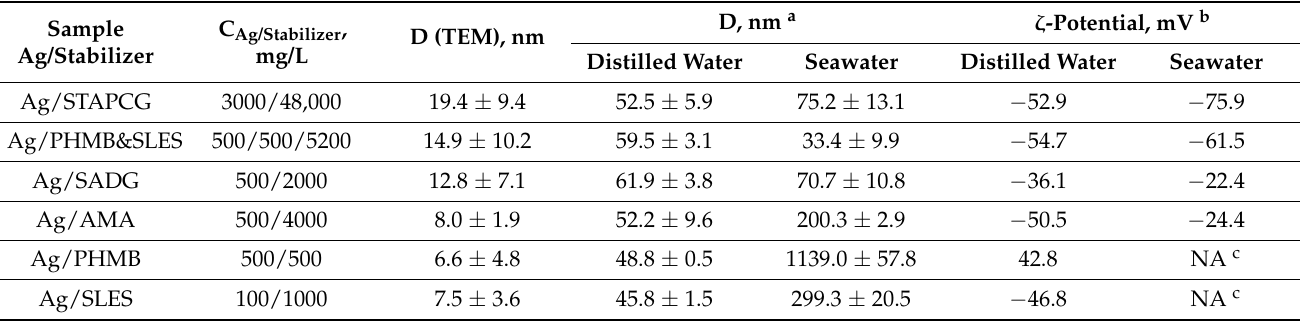
Table 1. Composition and physicochemical characteristics of the AgNPs used in the